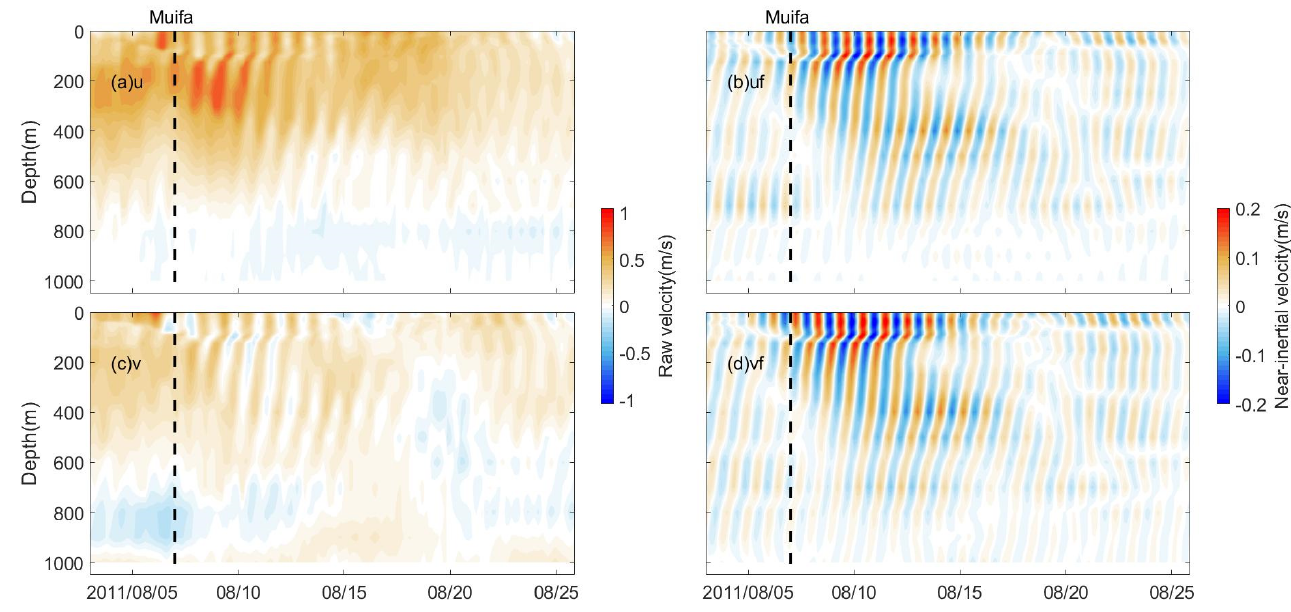
Figure 2. ( a , b ) Zonal and ( c , d ) meridional velocities of ( a , c ) raw HYCOM reanalysis data and ( b , d ) filtered NIWs as a function of time and depth. The vertical dashed line in each subfigure denotes the time when Muifa passed.